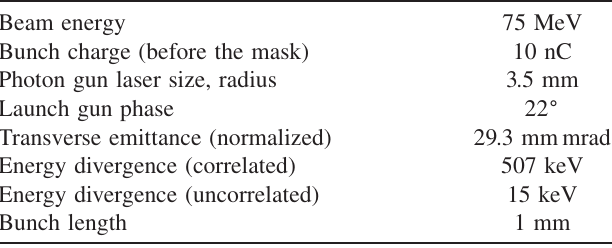
TABLE I. AWA injected beam parameters used in the simula- tion.